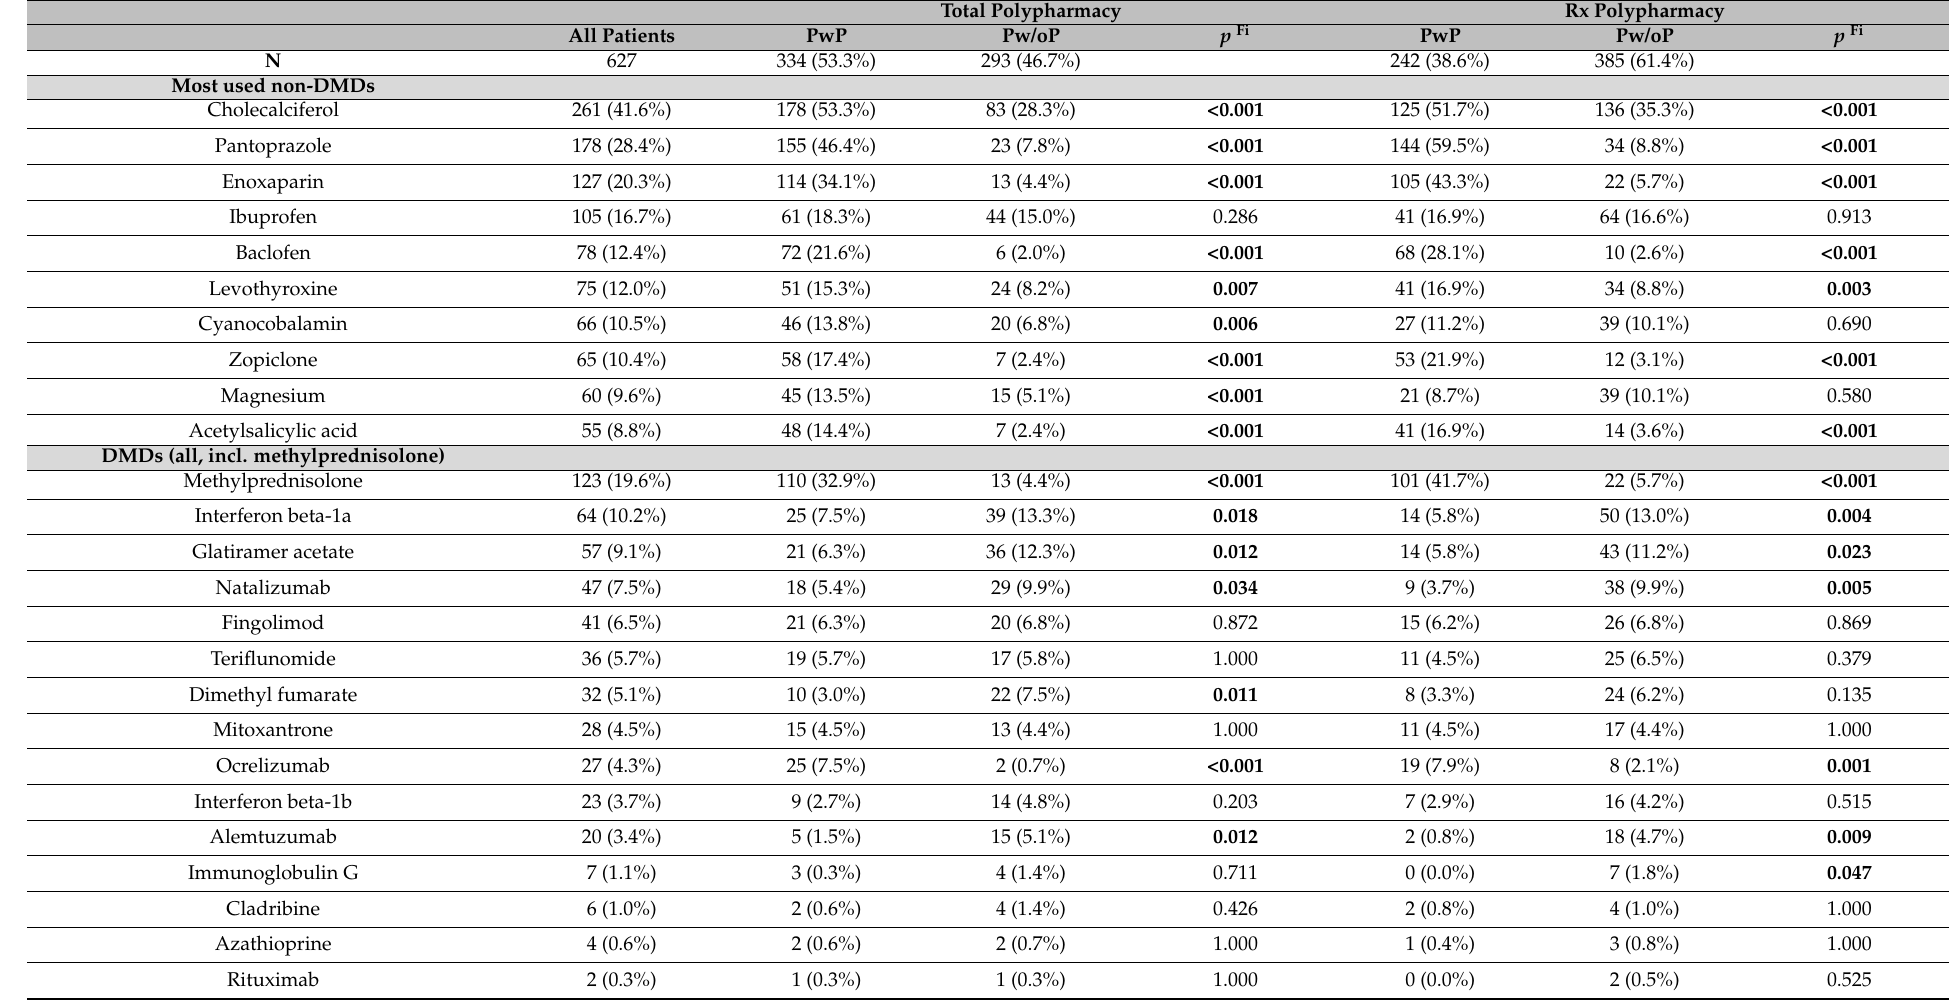
Table 3. Most frequently used non-DMDs and DMDs among MS patients with and without